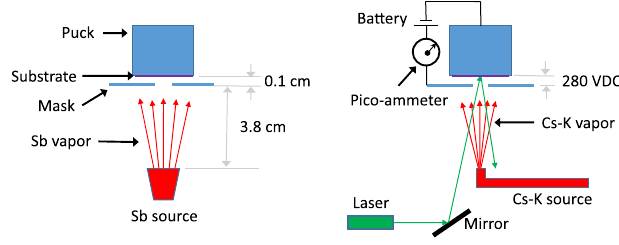
FIG. 3. Schematic of the fabrication. Two major steps of fabricating photocathodes. Left: deposition of Sb. Right: code- position of Cs and